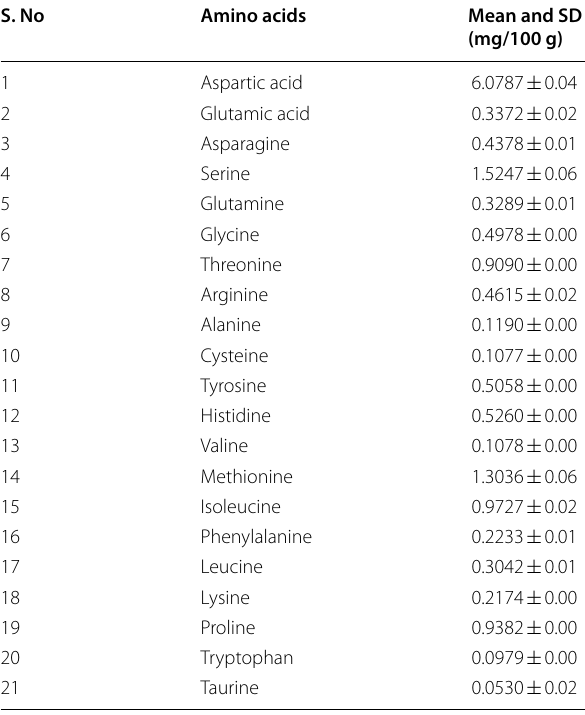
Table 5 Amino acid contents of Coiblemmus